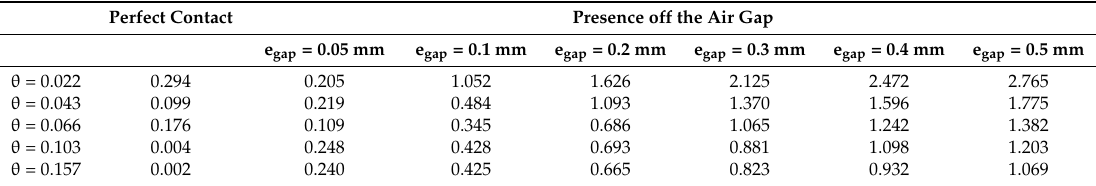
Table 4. Relative error on water content estimation with Onset method and LRM.